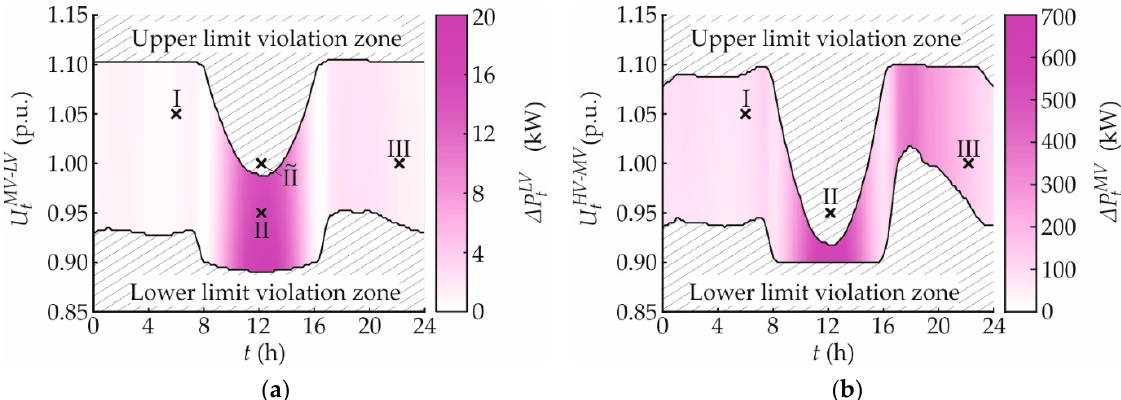
Figure 14. Daily active power loss within different system levels for various boundary voltages and no Volt/var control: ( a ) LV level (rural LV_Link-Grid); ( b ) MV level.